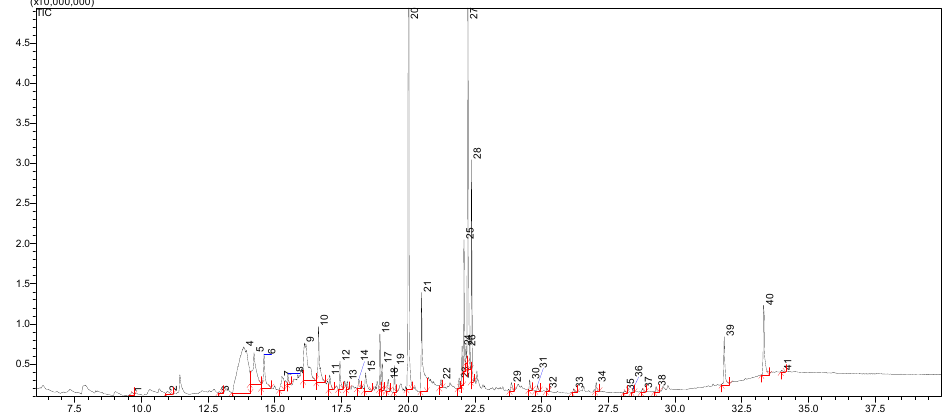
Figure 6. GC/MS chromatogram (in TIC mode) of C. hsingshangensis extract.